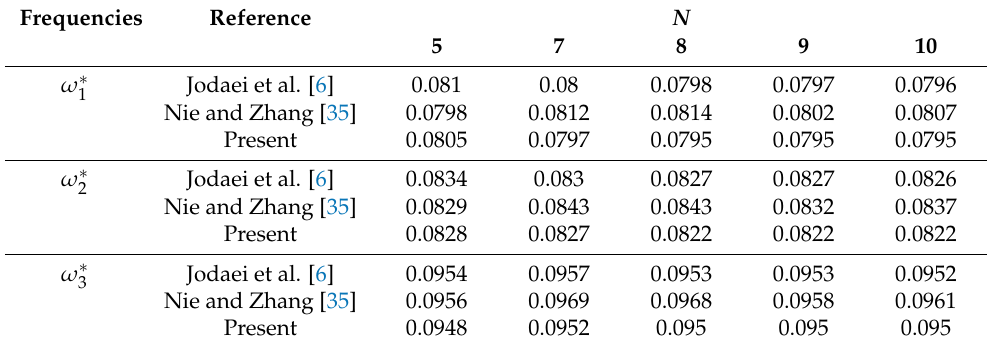
Table 3. Validation of present work with respect to Refs.